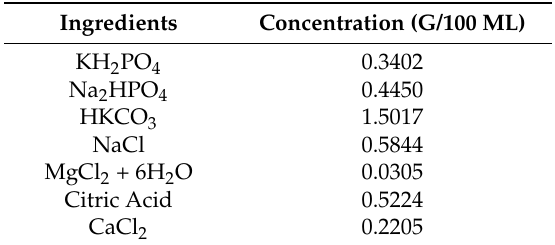
Table 2. Ingredients of artificial